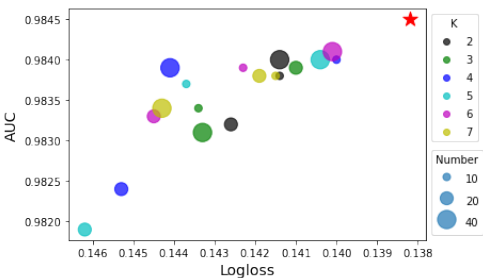
Figure 7. Effects of number of gated units on model performance.